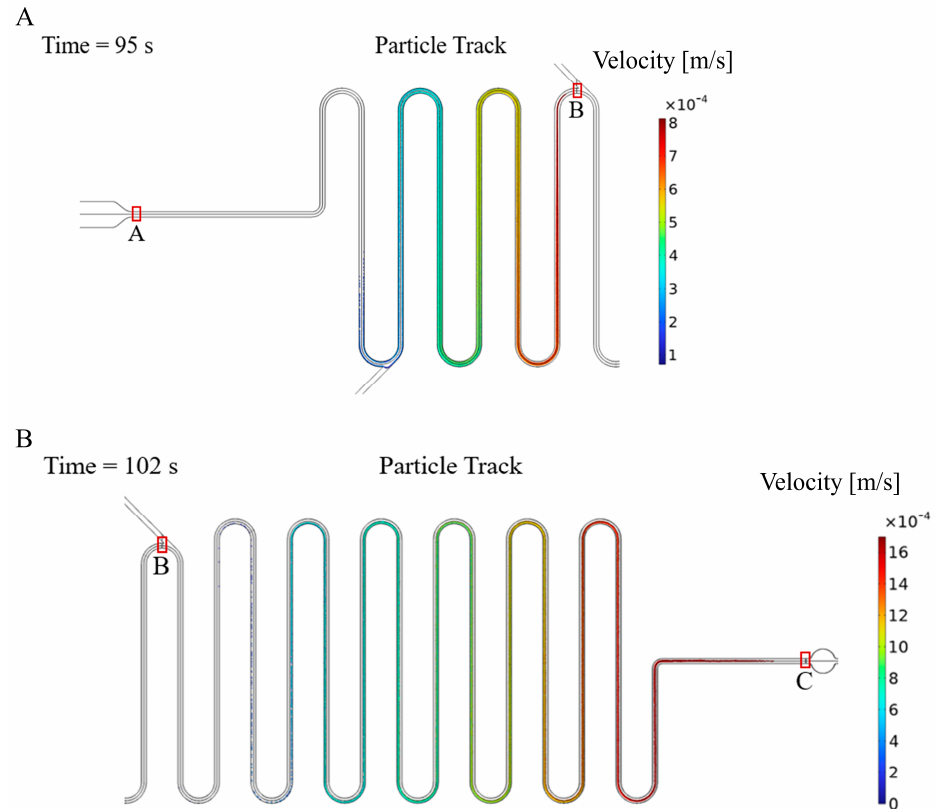
Figure 9. Particle trajectory when particles are released at point A ( A ) and point B ( B ), where point A is the exit of the cell culture chamber, point B is the junction of the main channel and the reagent channel and point C is the entrance of the detection